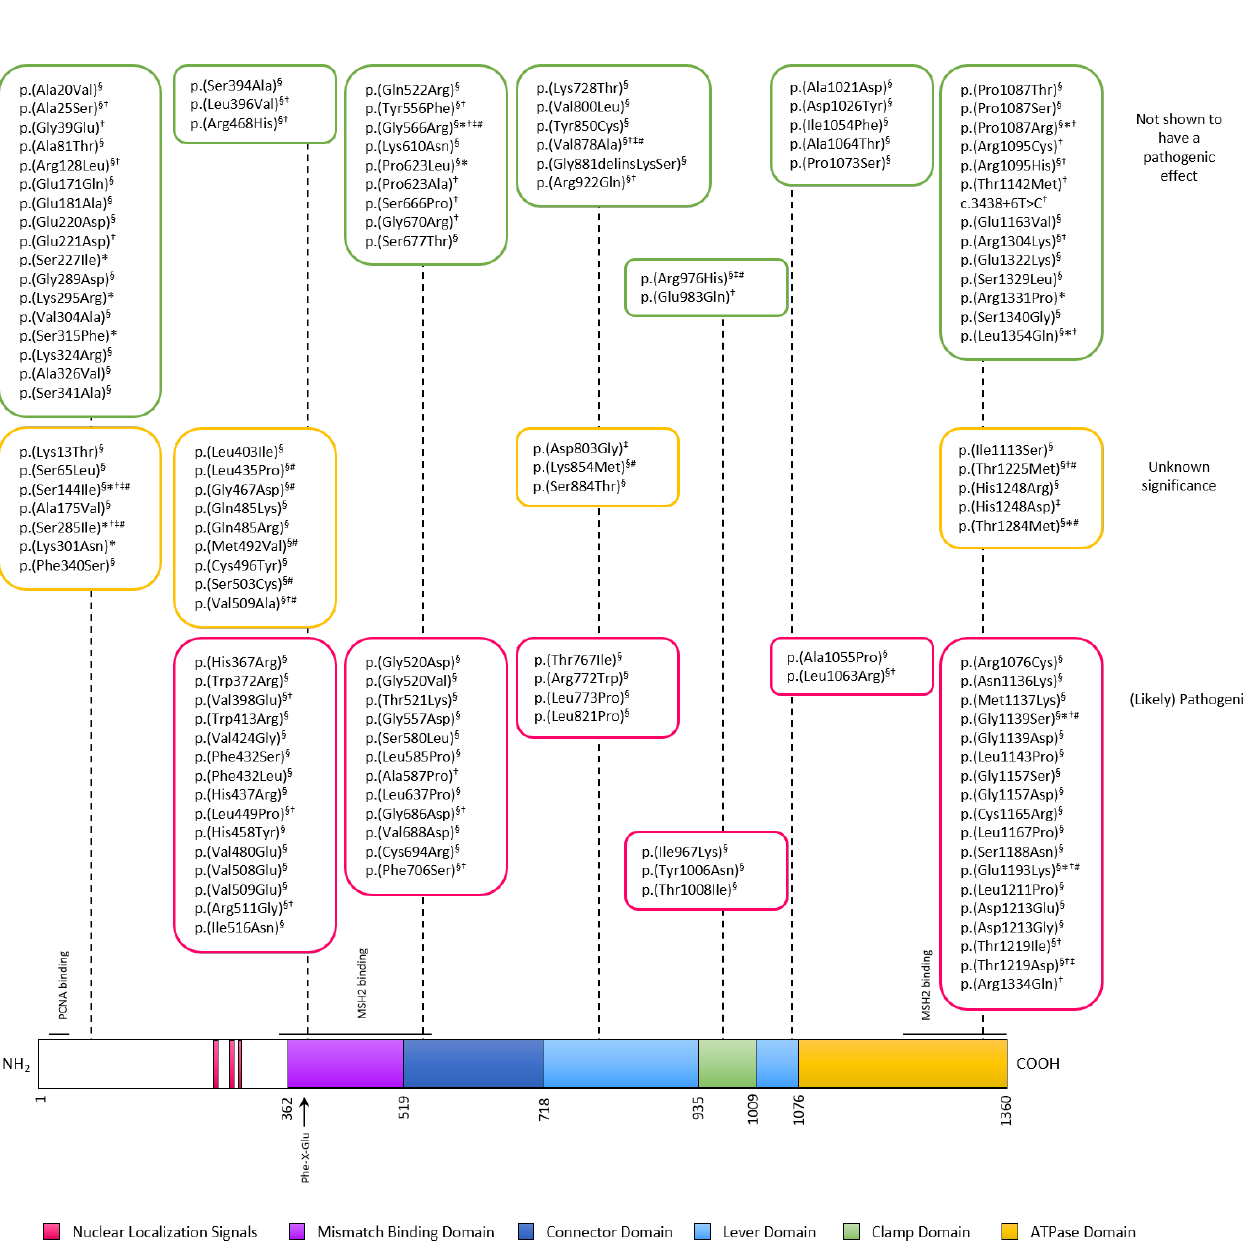
Figure 2. Structure of the MSH6 protein showing functional domains and the variants located within them on which functional analysis have been performed. The variants have been grouped according to the results of the functional assays. “Not shown to have a pathogenic effect”: variants that perform similarly to the wild type in the functional assays (green boxes). “Unknown significance”: variants that perform intermediate in the functional assays or give conflicting interpretations (yellow boxes). “(Likely) Pathogenic”: Variants with a functional effect (red boxes). The variants are marked to show which assays have been used: § : MMR activity assays, *: nuclear localization assays, † : 6-TG selection assays in mESC and ‡ : mechanistic assays. # : variants that give rise to conflicting interpretations in different assays.